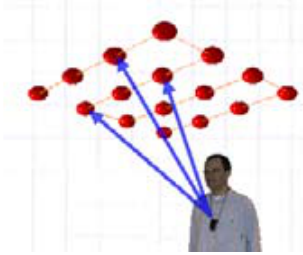
fig. 8. The principle of the Bat Ultrasonic Location System.